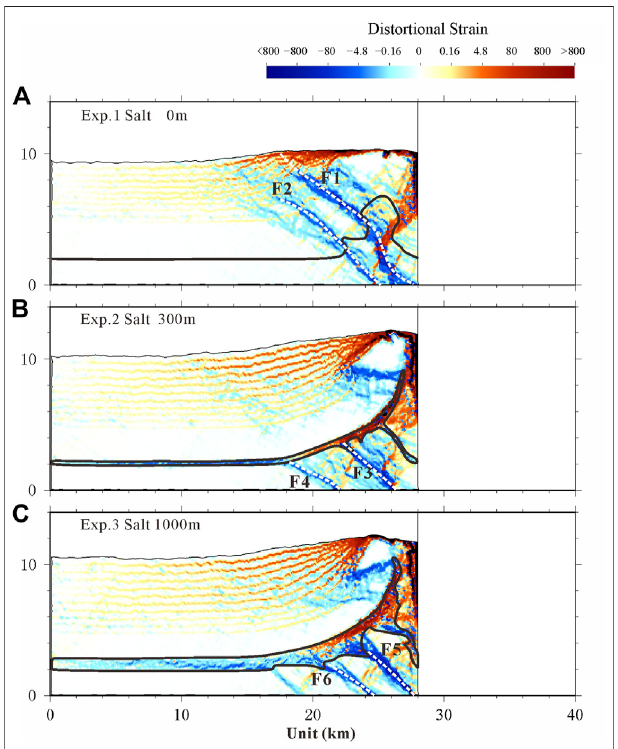
FIGURE 6 | Distortional strain illustrated after 12 km of shortening. (A) Reference experiment. (B) Experiment with thin salt (ca. 300 m). (C) Experiment with thick salt (ca. 1,000 m). Shear strain magnitude is shown by color intensity. Red denotes the top-to-the-right sense of shear; blue denotes the top-to-the-left sense of shear. Dashed lines denote faults. The areas that are trapped by the black solid line denote the salt. The fi gures of distortional strain for each step are included in the Supplementary Material .